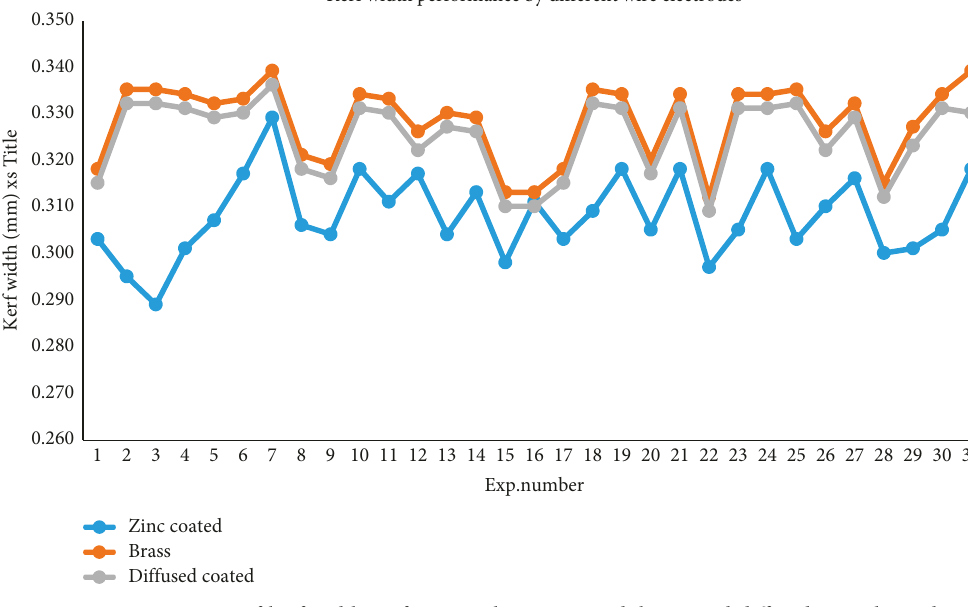
Figure 4: Comparison of kerf width performance by zinc coated, brass, and diffused wire